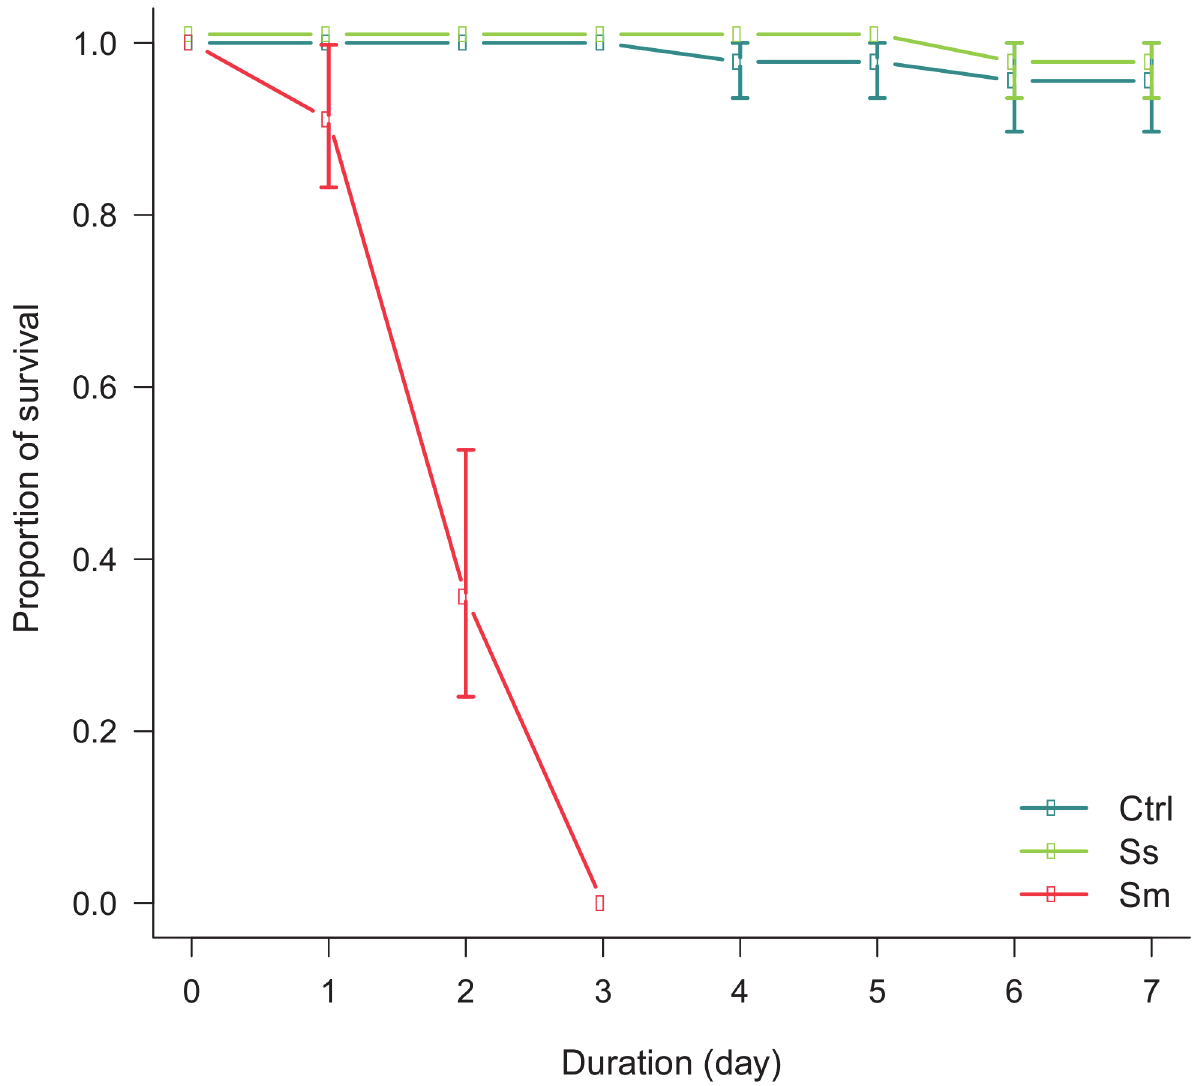
Fig 1. Survival of A . pisum aphids after bacterial ingestion. Graph show the survival of A . pisum aphids infected with S . marcescens Db11 (red), S . symbiotica CWBI-2.3 T (green) and uninfected aphids (blue). Error bars represent ± 95%